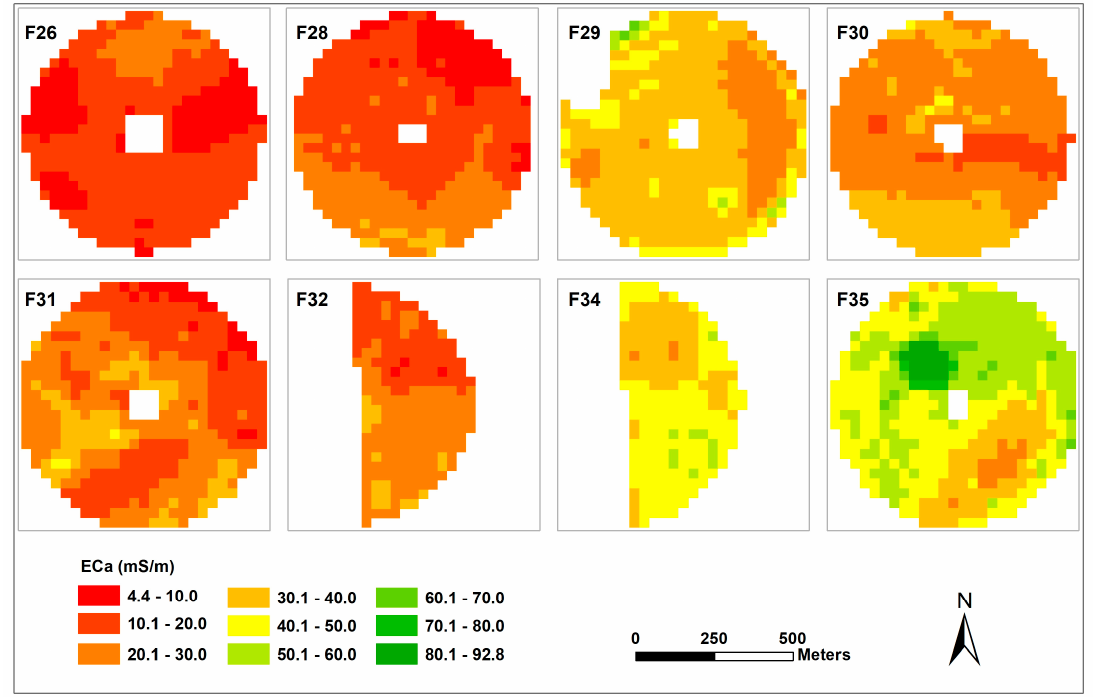
Figure 9. Variation of soil apparent electrical conductivity (EC a , 90 cm) in eight fields in the Southern High Plains.